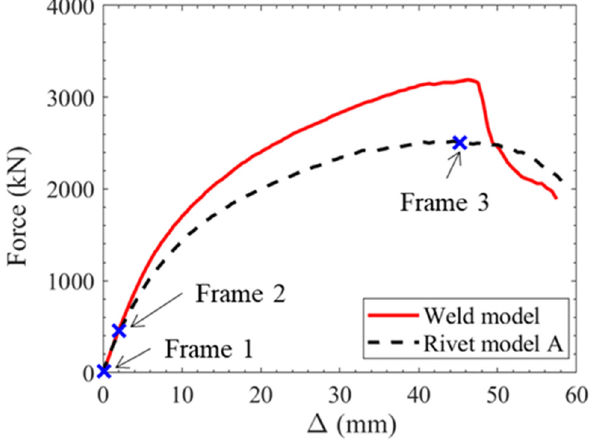
Figure 12. Force vs. displacement curve from the submodels of the welded and the riveted (model A) cases.